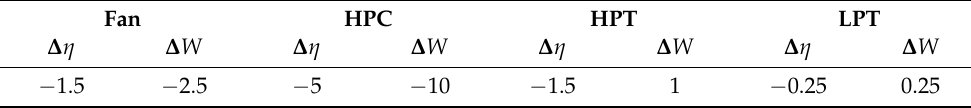
Table 6. Gradual degradation